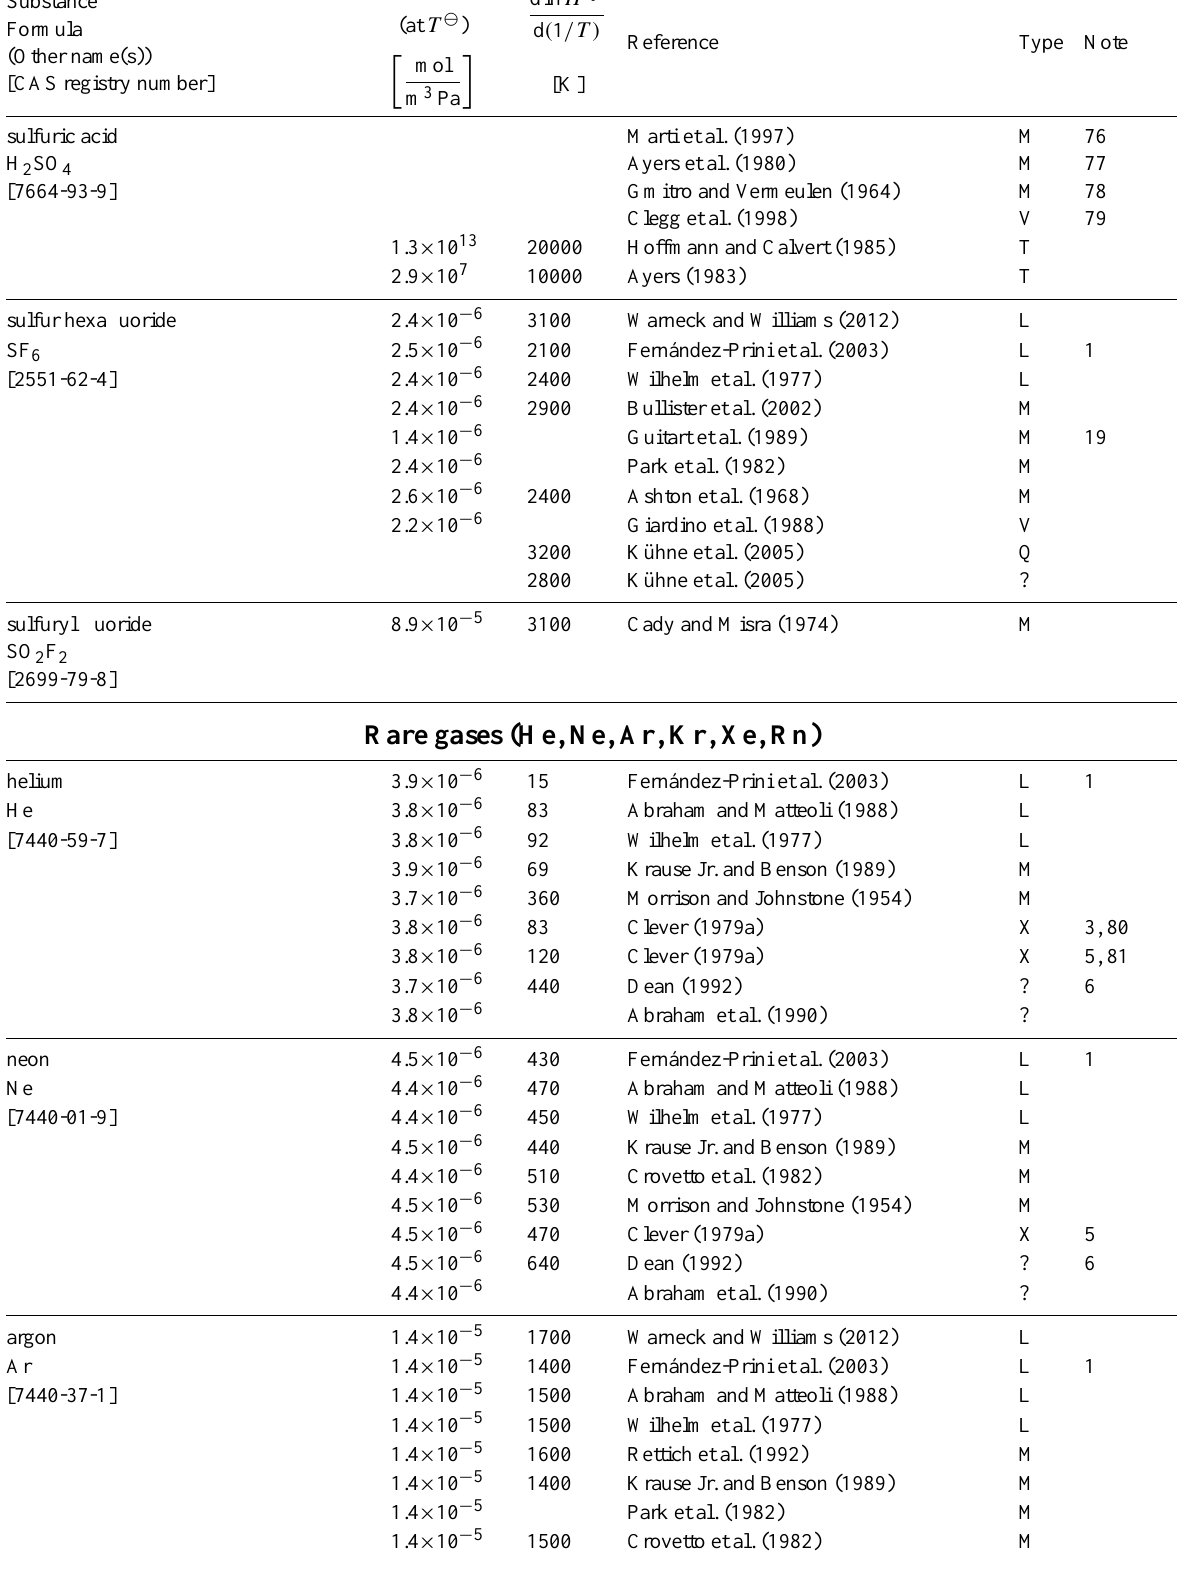
Table 6: Henry’s law constants for water as solvent